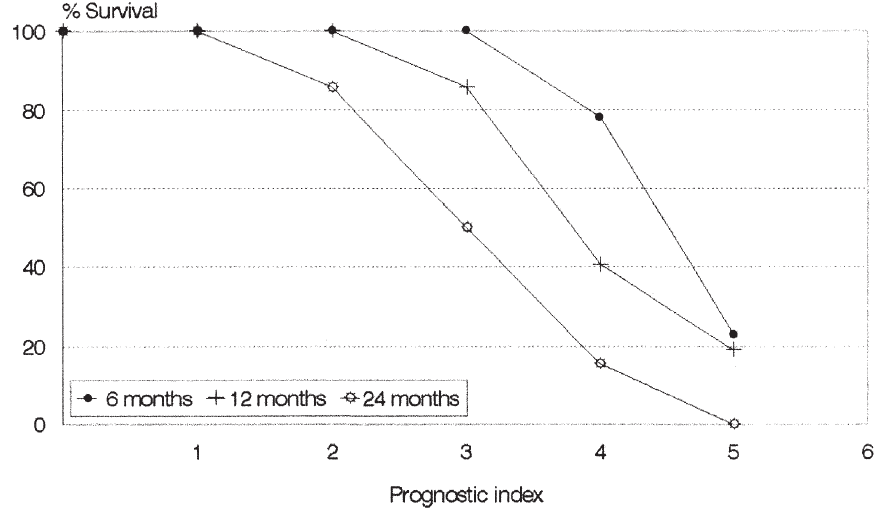
Fig. 3. Survival and prognostic index at 6, 12 and 24